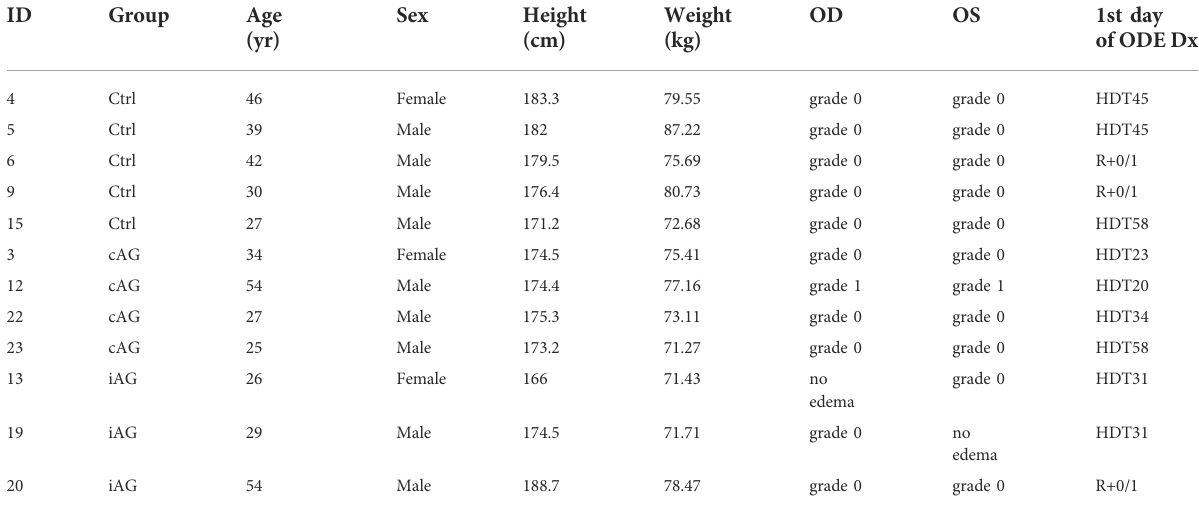
TABLE 6Resultsof opticdisc edema evaluation at theend ofthe 60-days HDT phase.OD( oculus dexter ):right eye;OS( oculus sinister ):left eye;ODE Dx: optic disc edema diagnosis. Frisén grade 0 corresponds to an optic disc edema of up to 2/3 of the disc, grade 1 corresponds to an optic disc edema > 2/3 of the